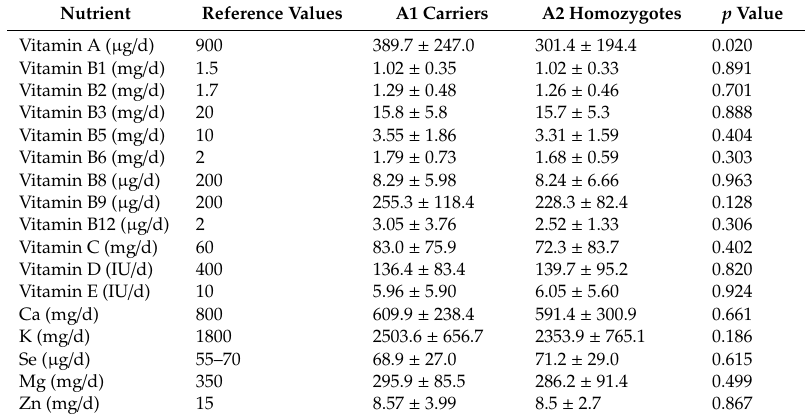
Table 3. Micronutrient intakes according to genotypes of the DRD2 / ANKK1 TaqIA polymorphism. Nutrient